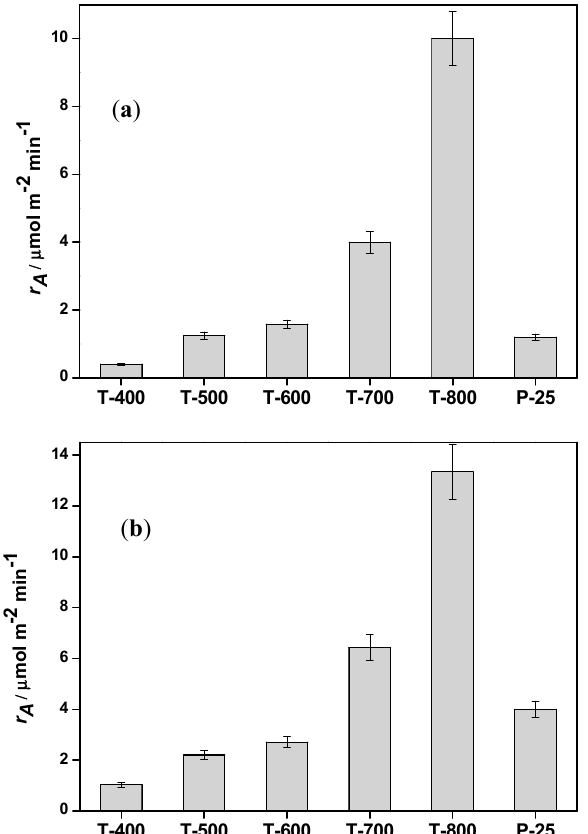
Figure 3. Comparison of the apparent degradation rate in the presence of commercial P-25, T-400, T-500, T-600, T-700, and T-800 photocatalysts for imazapyr ( a ) and for phenol ( b ). Photocatalyst loading, 1 g L − 1 ; (O 2 saturated, pH = 3; T = 25 ± 1 °C); reaction volume 50 mL.